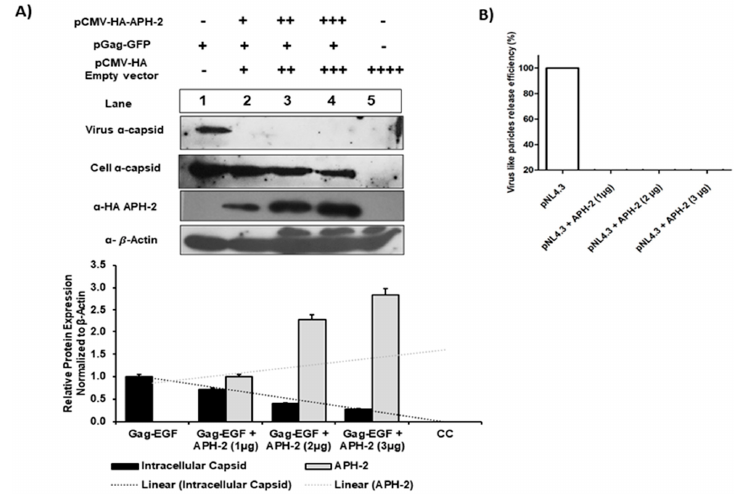
Figure 2. Role of APH-2 in HIV-1 release. ( A ) Effect of APH-2 on pGag-EGFP: 293T cells were transfected with HXB2 pGag-EGF (1 μ g) only and co-transfected with HXB2 pGag-EGF (1 μ g), along with increasing amounts of plasmid-encod- ing HA-APH-2 (1–3 μ g). Western blots were performed to examine cell-free virus-like particle production (Panel 1), cellu- lar Gag (pr55-EGFP) expression (Panel 2) and APH-2 expression (Panel 3). Bottom panel: Cellular beta actin expression represents the loading control. (Amount of plasmid used is represented in fi gure as − = 0 μ g; + = μ g; ++ = 2 μ g; +++ = 3 μ g ; ++++ = 4 μ g). The graph below shows densitometric analysis of Western blot performed using Image J software, and relative cellular protein expression normalized to β -actin. ( B ) HIV-1 virus release efficiency: Densitometric analysis was performed using NIH Image J software and a graph was plotted for average percent change in Gag expression. The effi- ciency of virus release was calculated as the amount of virion-associated mature capsid protein, p24, as a fraction of the total amount of Gag (virion-associated p24 plus all the cellular precursors of Gag) relative to pGag-EGFP, which was arbitrarily set at 100.